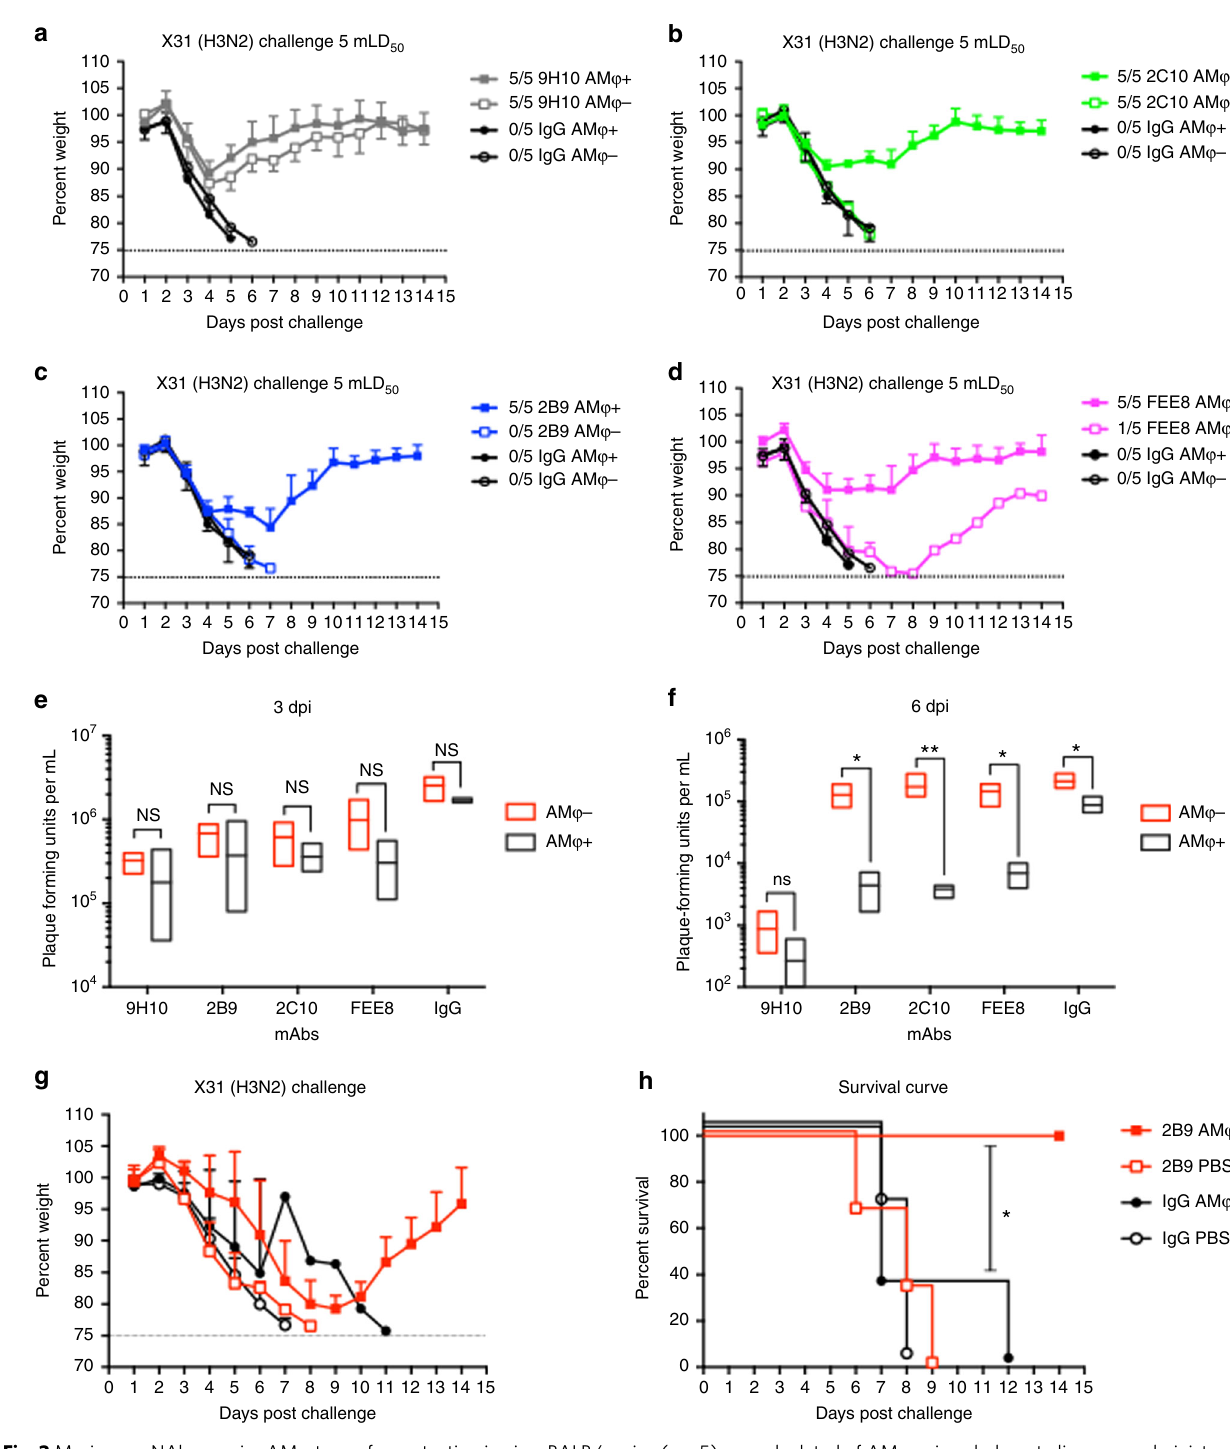
Fig. 3 Murine nonNAbs require AM φ to confer protection in vivo. BALB/c mice ( n = 5) were depleted of AM φ using clodronate liposome administered IN. PBS-liposome-treated mice were used as controls. Mice were injected IP with 15 mg per kg: ( a ) 9H10, ( b ) 2C10, ( c ) 2B9, or ( d ) FEE8 5 h before a challenge with 5 mLD 50 of X31 virus. Weight change was monitored daily. The ratios in the fi gure legends indicate the number of animals that survived challenge over total number of animals per group. A mAb against GST was used as an IgG control. At ( e ) 3 and ( f ) 6 dpi, viral lung titers were determined by plaque assays. g , h GM-CSF knockout mice were reconstituted with 200,000 cells per 50 µ L of wild-type AM φ collected from C57BL/6J mice. Twenty-four hours post adoptive transfer, these mice ( n = 3 – 4 mice per group) were administered with 15 mg per kg of mAb 2B9 or IgG control. Two hours post administration of mAbs, mice were challenged with a lethal dose of X31. The ( g ) weights and ( h ) survival were monitored for 14 days. Statistical signi fi cance was determined using two-way ANOVA and Sidak ’ s multiple comparisons tests (GraphPad Prism). For all panels: * P ≤ 0.05, ** P ≤ 0.01, not signi fi cant (NS). Values represent mean ±